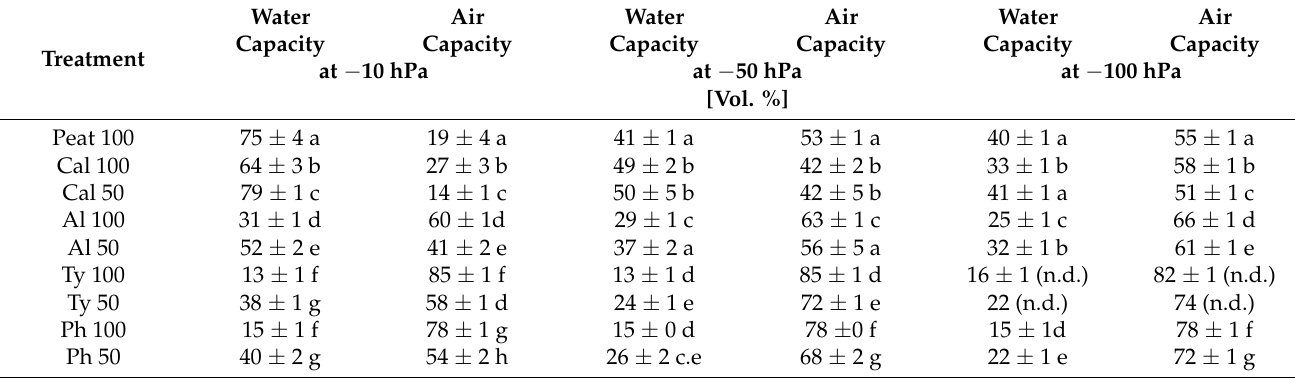
Table A1. Water and air capacity of the different treatments at − 10 hPa, − 50 hPa, and − 100 hPa in stage 1 determined according to DIN EN 13041 ([22]; n = 4. except − 100 h Pa: Ty 100 n = 2. Ty 50 n = 1. Ph 50 n = 5). variance analysis: Kruskal–Wallis (except air capacity at − 100 hPa: ANOVA). Post hoc test: pairwise t test. p < 0.05. At − 100 hPa Ty 100 and Ty 50 were excluded from statistical analysis. Different letters indicate significant differences among treatments. Explanation of treatment names see Table 1.